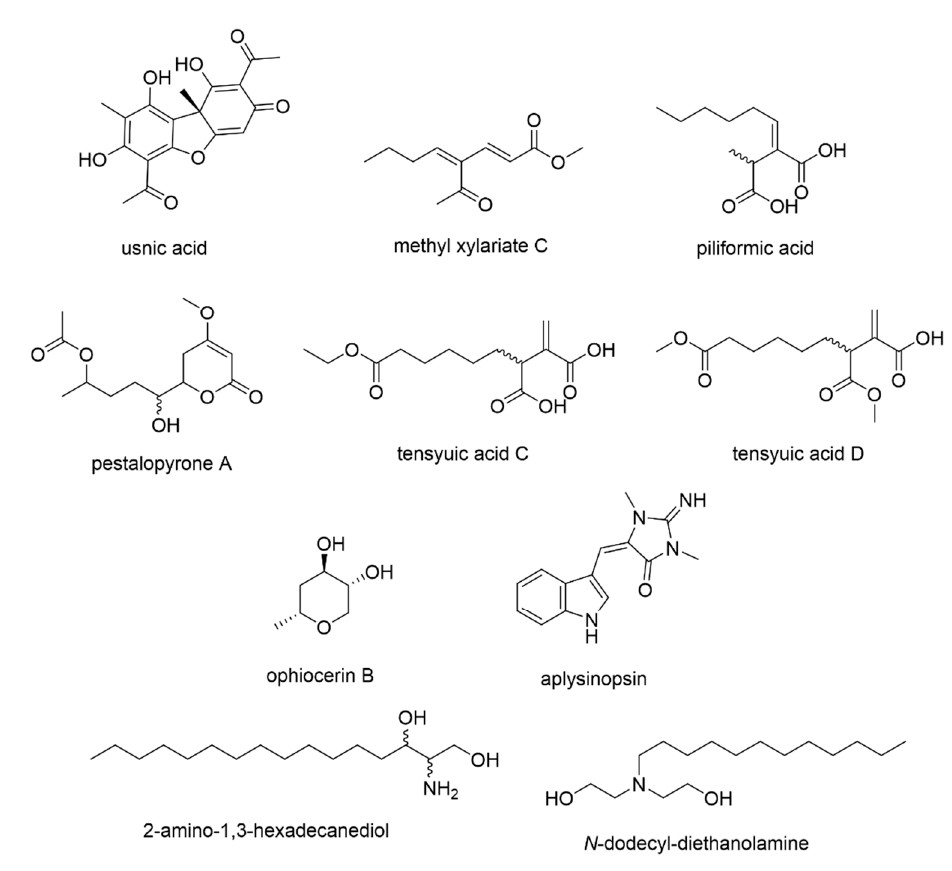
Figure 5. Structures of putatively dereplicated metabolites with usnic acid used as reference standard for lichen extracts in this study. Table 3. Discriminating secondary metabolites for ion peaks of X. venustula MH370742 putatively dereplicated from Dic- tionary of Natural Products (DNP) database.